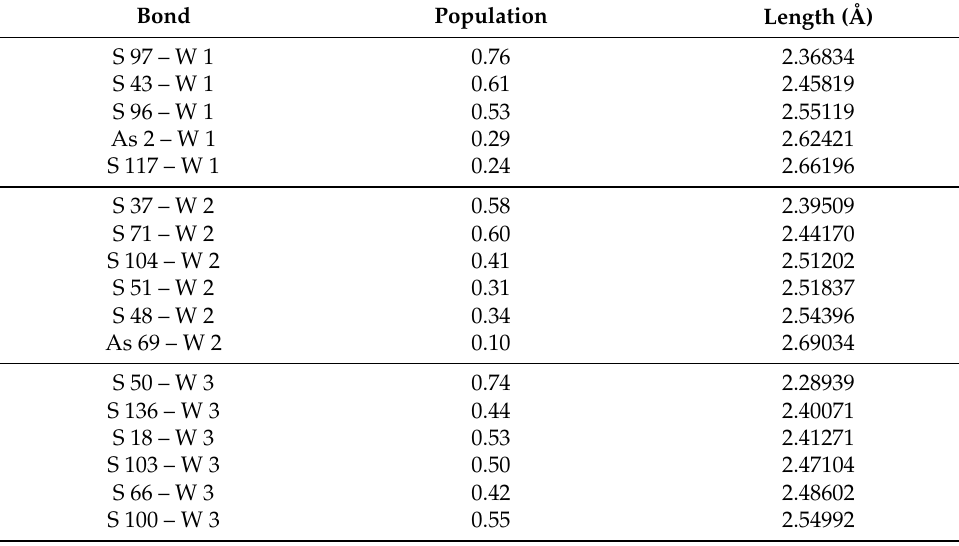
Table A11. Bond populations for mq As 2 S 3